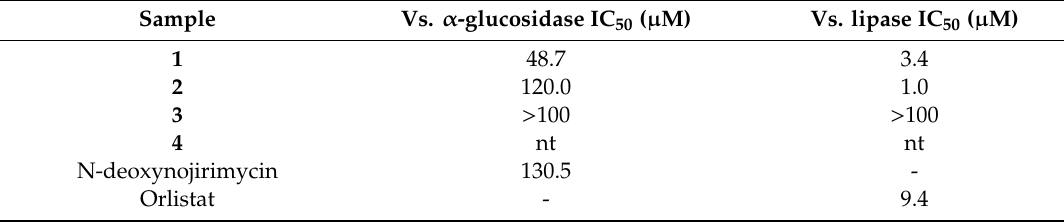
Table 1. α -Glucosidase- and lipase-inhibitory activities of compounds 1–4.